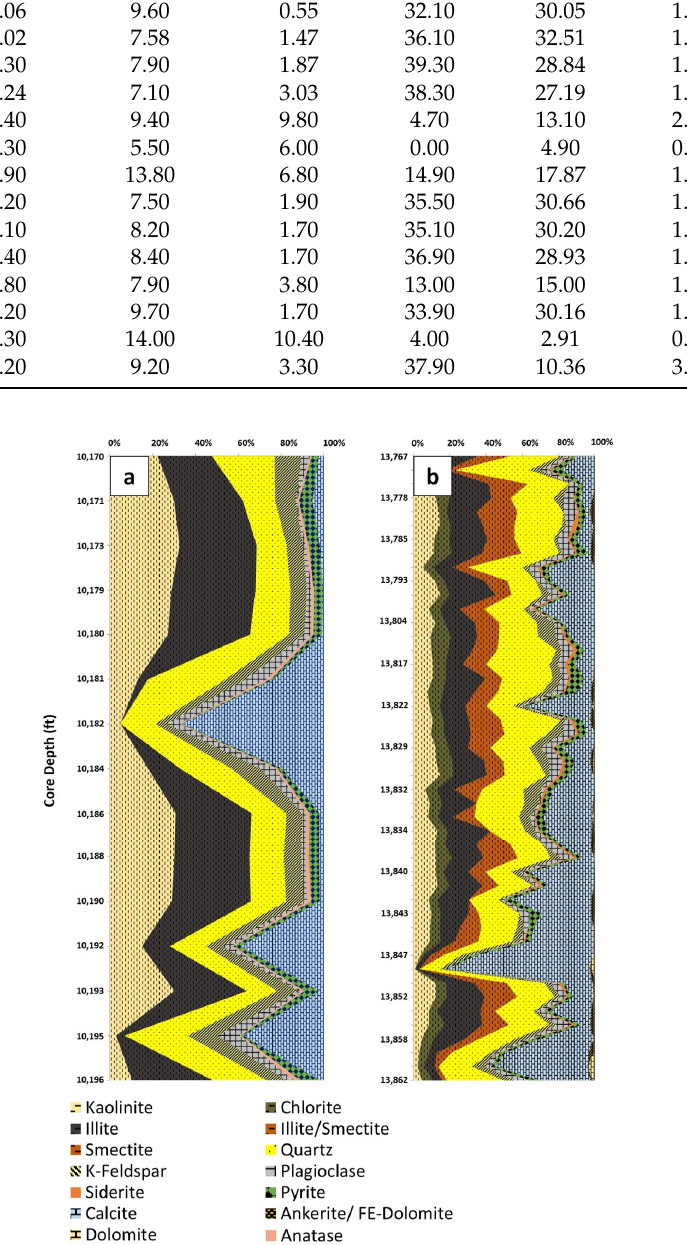
Figure 4. Whole-rock XRD mineralogy for: ( a ) Well CFU 31F-2 in Cranfield field, MS, and ( b ) a well in the East Feliciana Parish, LA.